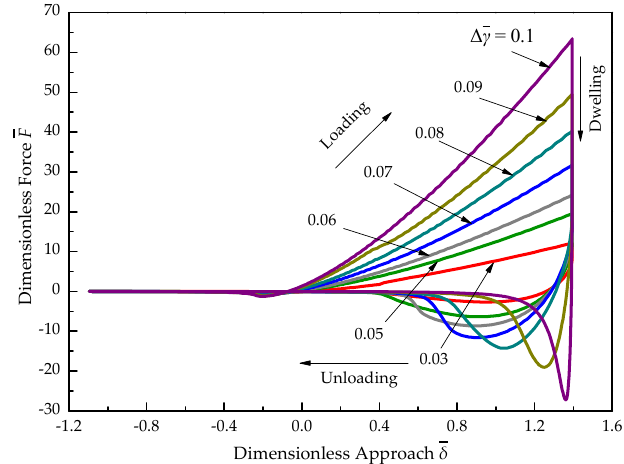
Figure 9. Force-approach curves for different thermodynamic work of adhesion under the condition of 𝛿̅ max = 2.49 and 𝑣̅ unload = 0.6.